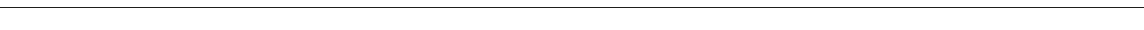
Fig. 3 Ubiquitylated BLM at the DSBs interacts with NBS1. a , b RNF8-dependent polyubiquitylation of BLM is required for its interaction with NBS1. (Top) a , b In vitro ubiquitylated BLM WT or BLM 3K was probed with anti-BLM antibody. (Middle) a , b Exogenous NBS1, immunoprecipitated from HEK293T cells (±NCS), was probed with anti-Myc tag antibody. (Bottom) a , b Interaction carried out with either polyubiquitylated or non-ubiquitylated BLM and bound Myc-tagged NBS1 was detected with anti-BLM antibody. c Ubiquitylation is essential for BLM to interact with NBS1 in vivo. HCT116 BLM ( − / − ) cells ( + NCS) were transfected with either EGFP-C1 BLM (WT) or (3K). (Top) Lysates were probed with antibodies against GFP, NBS1, hsp90. (Bottom) Lysates were immunoprecipitated with antibody against NBS1 and probed with anti-NBS1 and anti-GFP antibodies. d Lack of RNF8 prevents the interaction between BLM and NBS1. (Left) U2OS – AsiSi – ER cells were transfected with siControl or siRNF8. Extracts were probed with anti-RNF8, anti-BLM, anti-NBS1, anti- hsp90 antibodies. (Right) Immunoprecipitations, carried out with either anti-BLM antibody or IgG, were probed with anti-BLM, anti-NBS1 antibodies. e Polyubiquitylated BLM is complexed with NBS1 but not MRE11. (Top) RNF8-dependent in vitro ubiquitylation of BLM WT, in the presence of Ub WT or